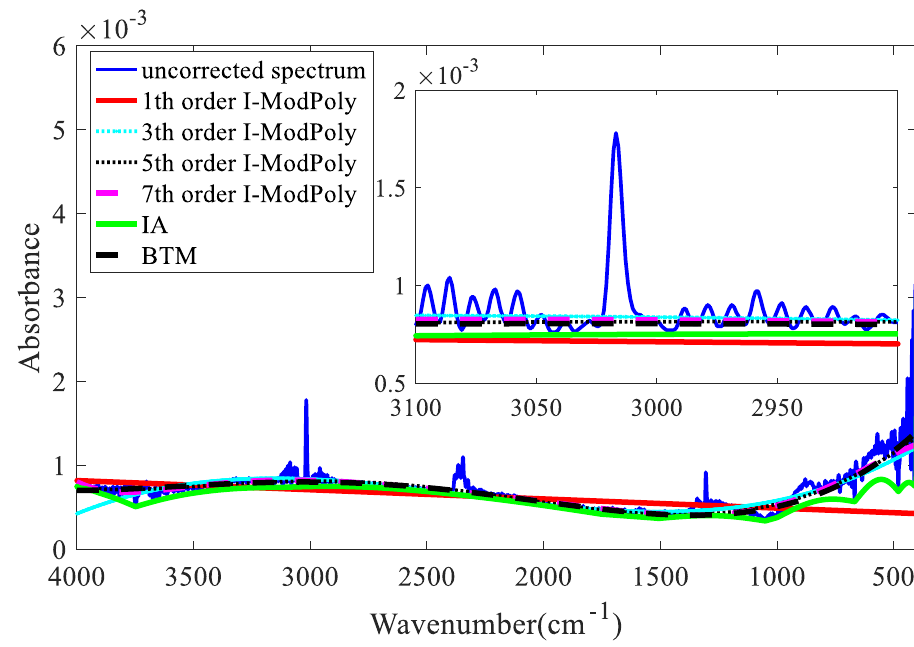
Figure 11. Baselines corrected by BTM and the IA and I-ModPoly methods.